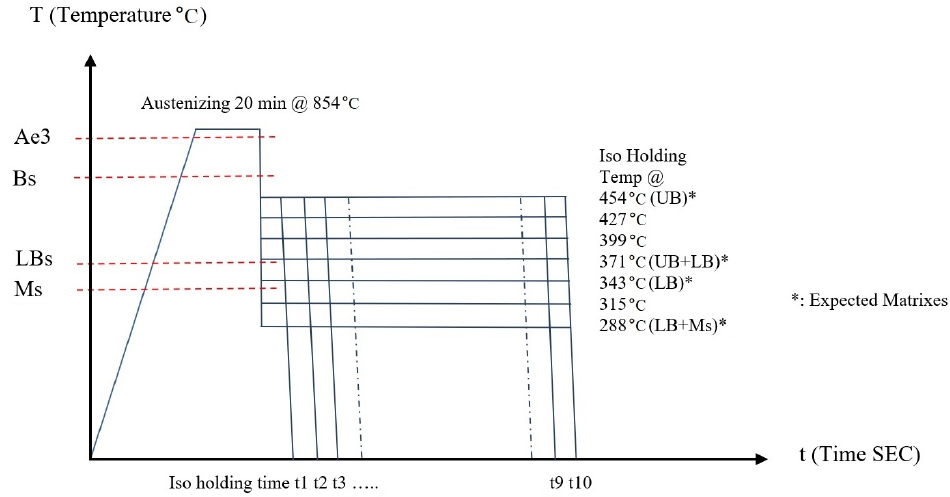
Figure 1. Isothermal processing experiment scheme.